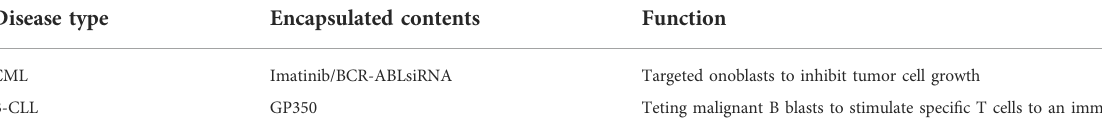
TABLE 10 Engineered exosomes in the hematological